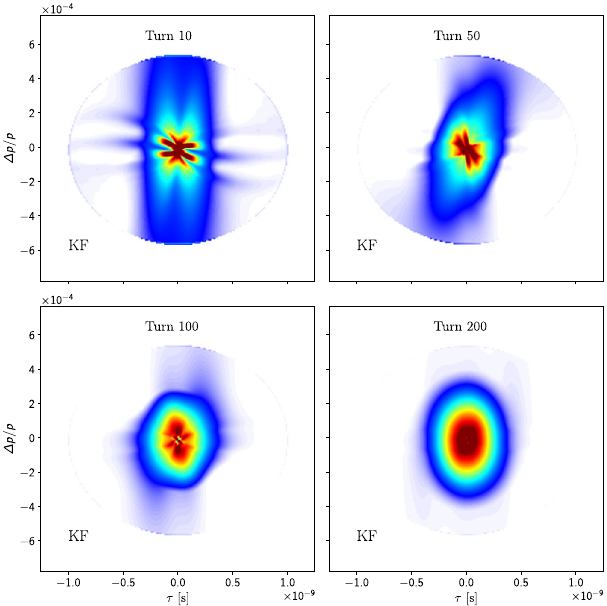
FIG. 6. Early steps of the Kalman filter phase-space reconstruction in the case of the well-centered stationary